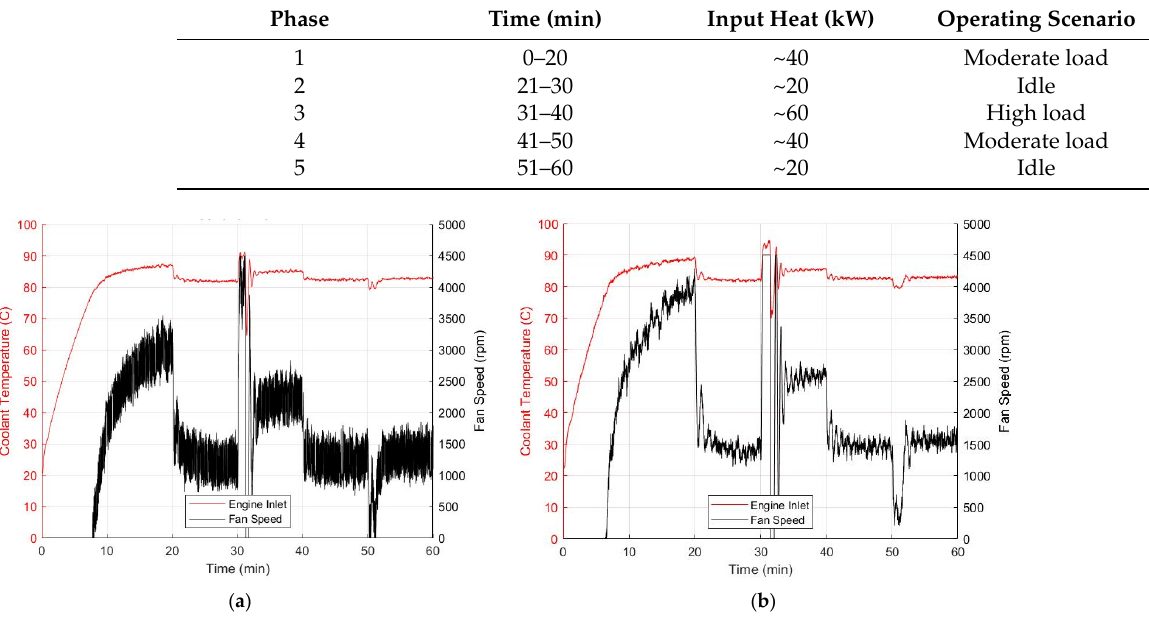
Figure 7. Engine coolant temperature profile with the respective fan speed for the ( a ) sliding mode and ( b ) classical controllers.